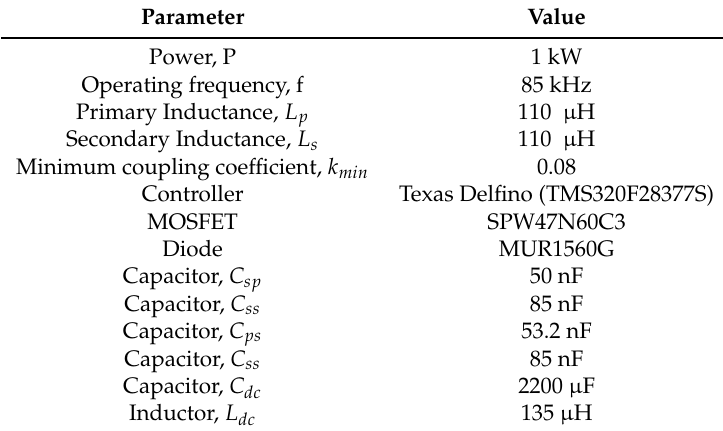
Figure 14. Operating frequency corresponding to misalignment. ( a ) Operating frequency corresponding to the vertical misalignment. ( b ) Operating frequency corresponding to the horizontal misalignment. Table 1. Circuit parameters and